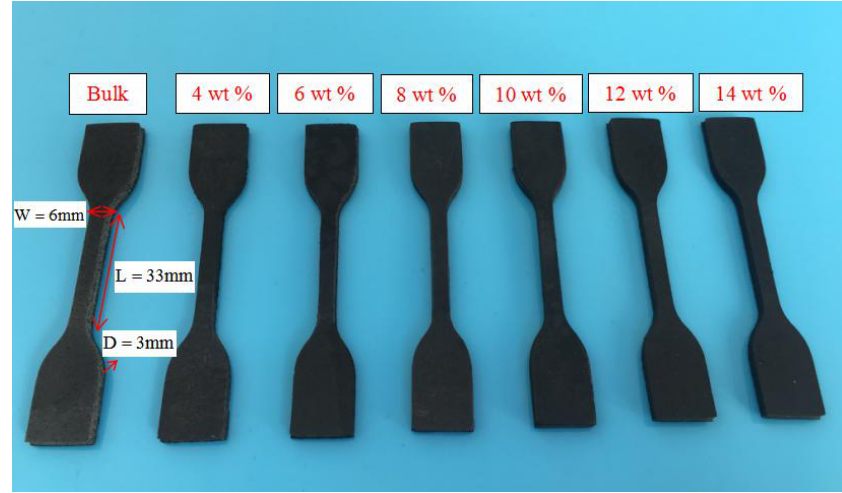
Figure 3. TPI SMPC specimens.